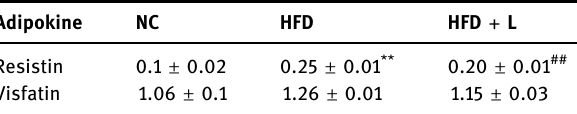
Table 2: E ff ect of liraglutide on serum adipokine levels